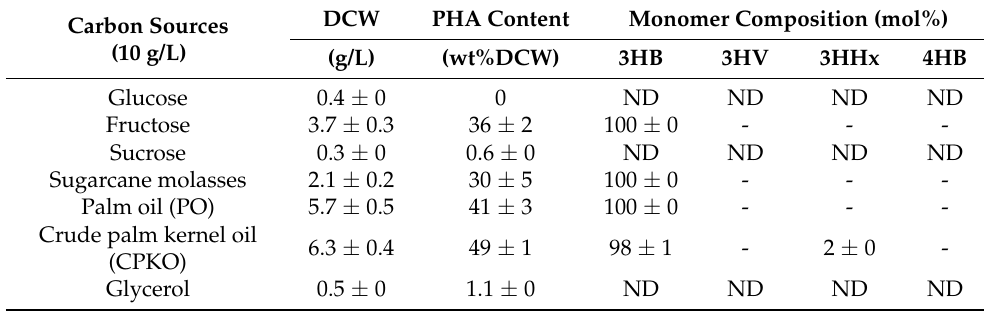
Table 2. PHA biosynthesis by C. necator PHB − 4/pBBR_CnPro- phaC Rp using different carbon sources in shake flask